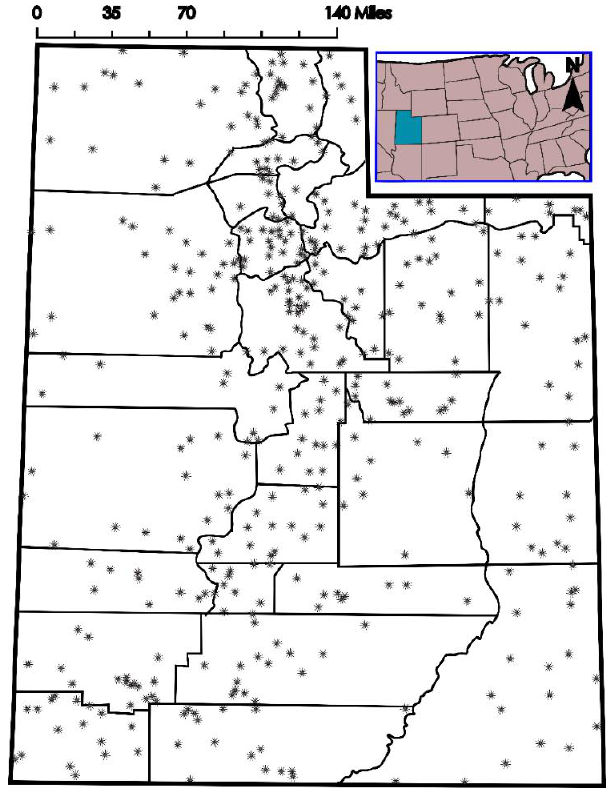
Figure 1. Location of the study area and position of temperature stations.